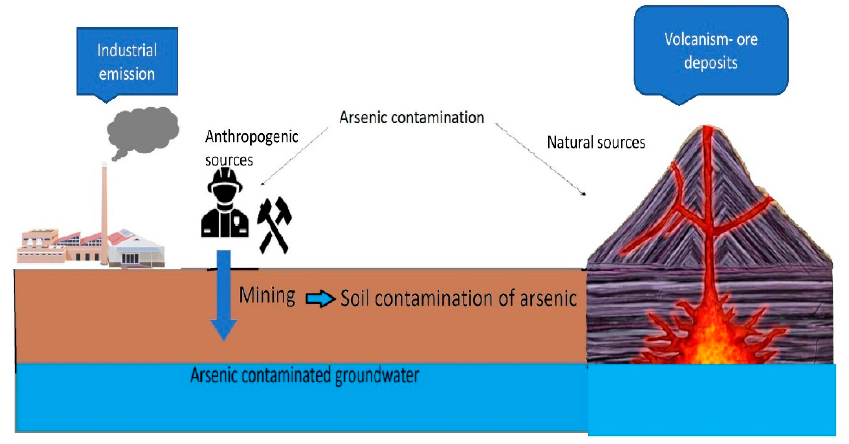
Figure 1. Sources of arsenic contamination in the